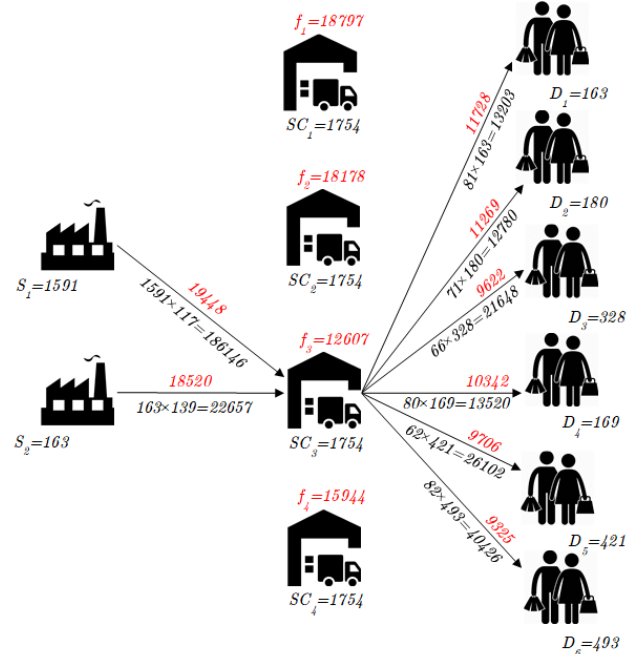
Figure 3. An illustrative example of the of the two-stage supply chain network design problem with fixed costs and the obtained optimal